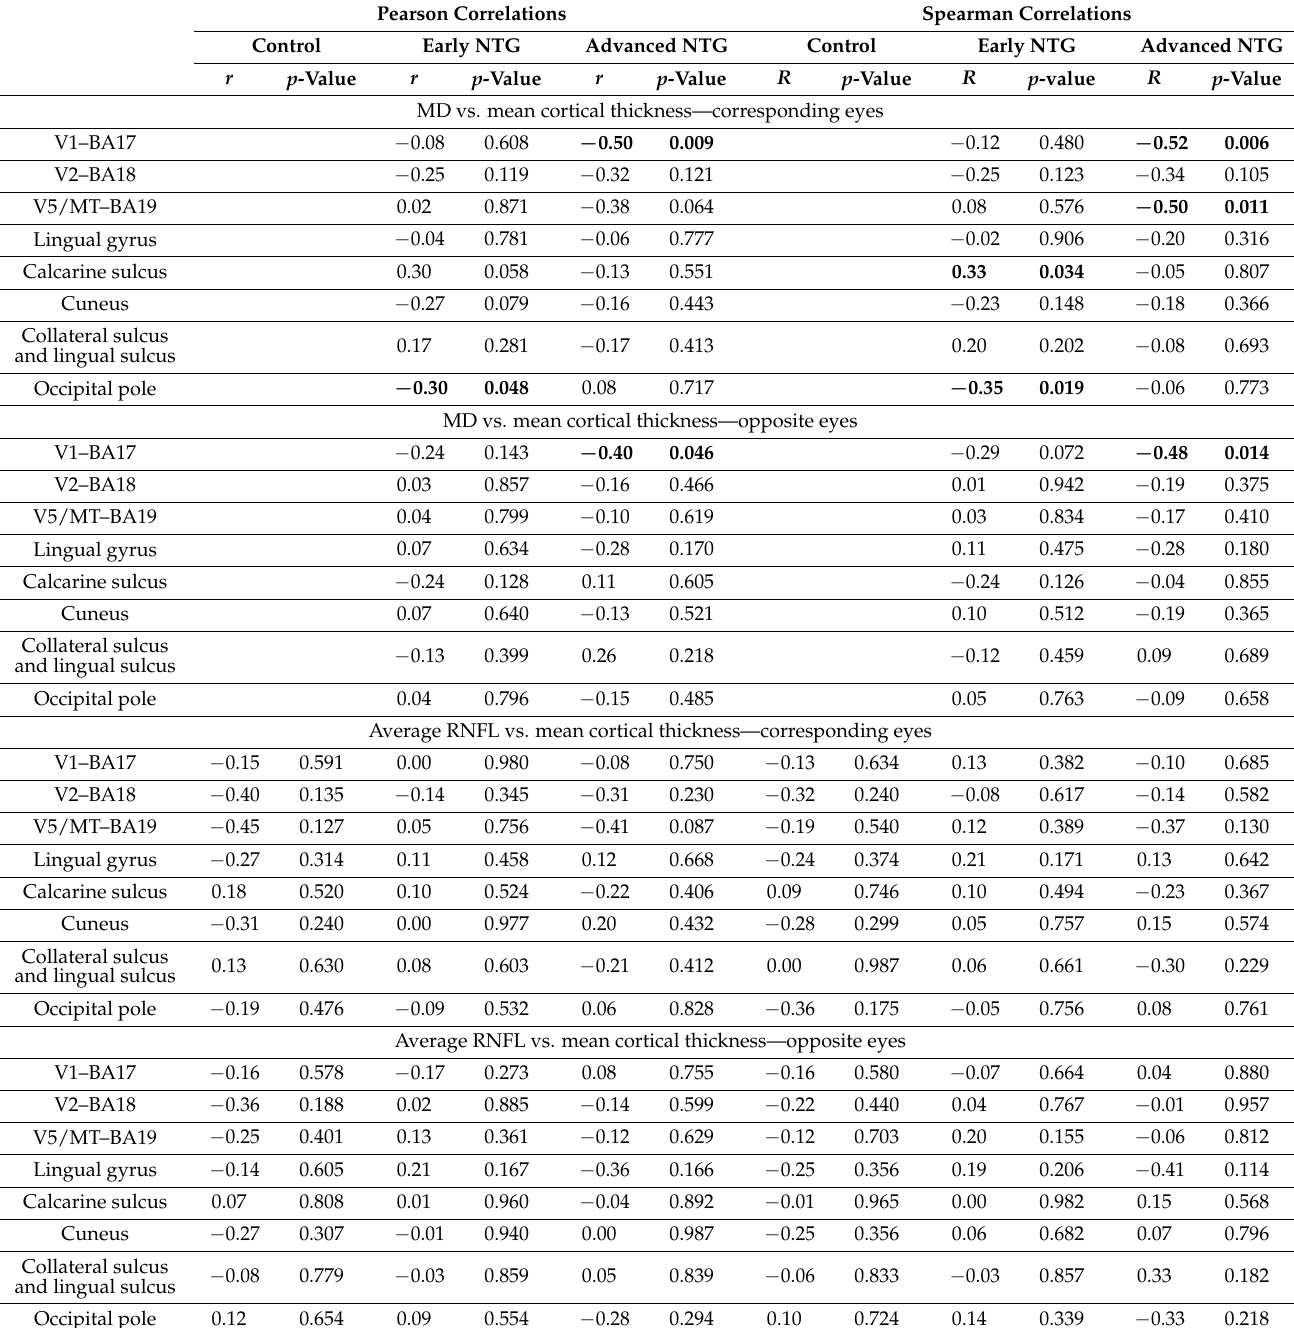
Table 5. Parametric (Pearson’s) and nonparametric (Spearman’s) correlation analyses between mean cortical thickness in selected areas and the clinical parameters (MD and RNFL) in studied groups. Statistically significant results are marked